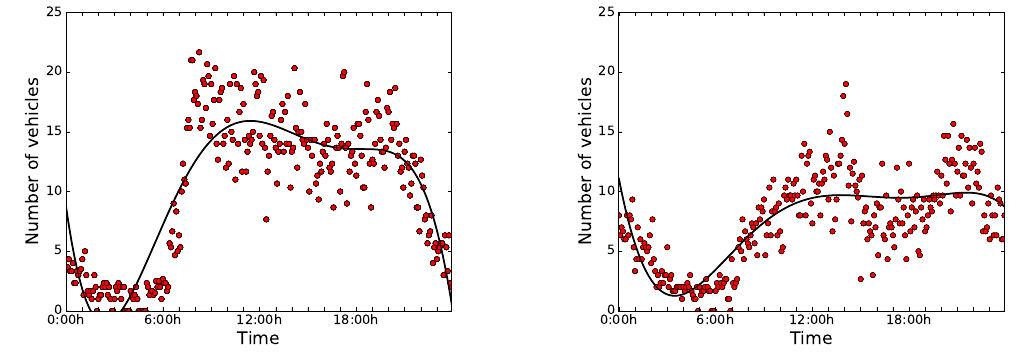
Figure 9. Data distributions and selected